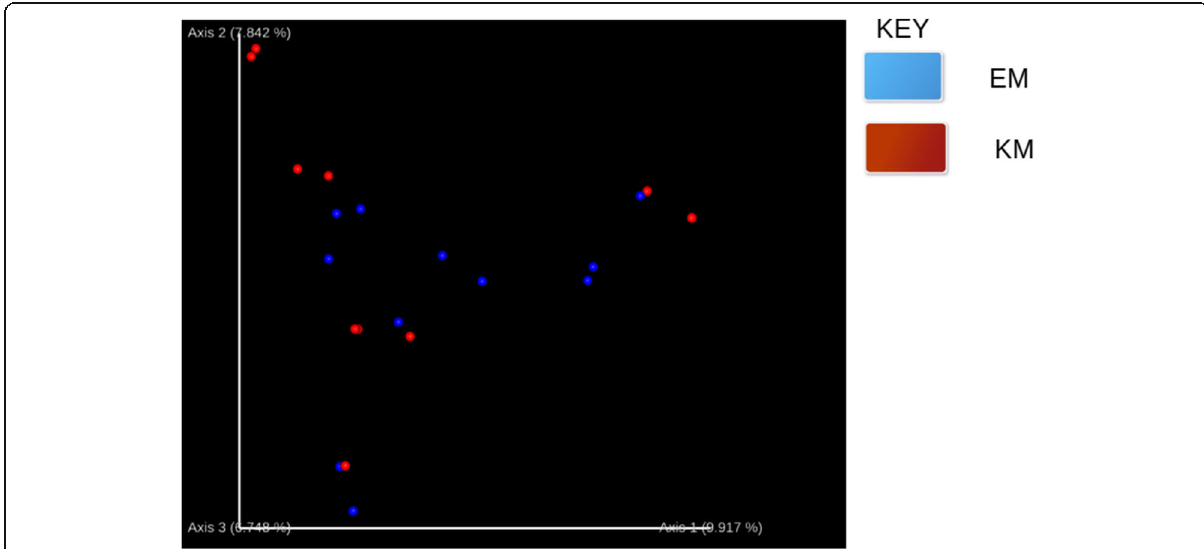
Fig. 4 Principal coordinate analysis of prokaryotic metagenome in vended food and environmental samples from Embu Town and Kangaru